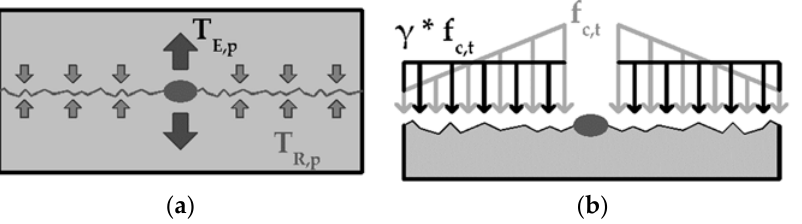
Figure 8. ( a ) Acting (T E,p ) and reacting (T R,p ) forces along a crack parallel to the textile plane; ( b ) transfer of the reacting concrete stresses into a stress block.